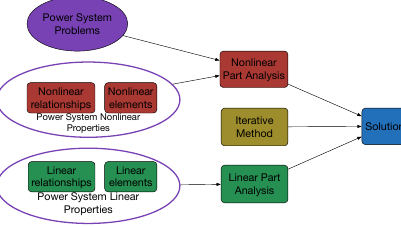
Figure 8. Power system analysis with the proposed